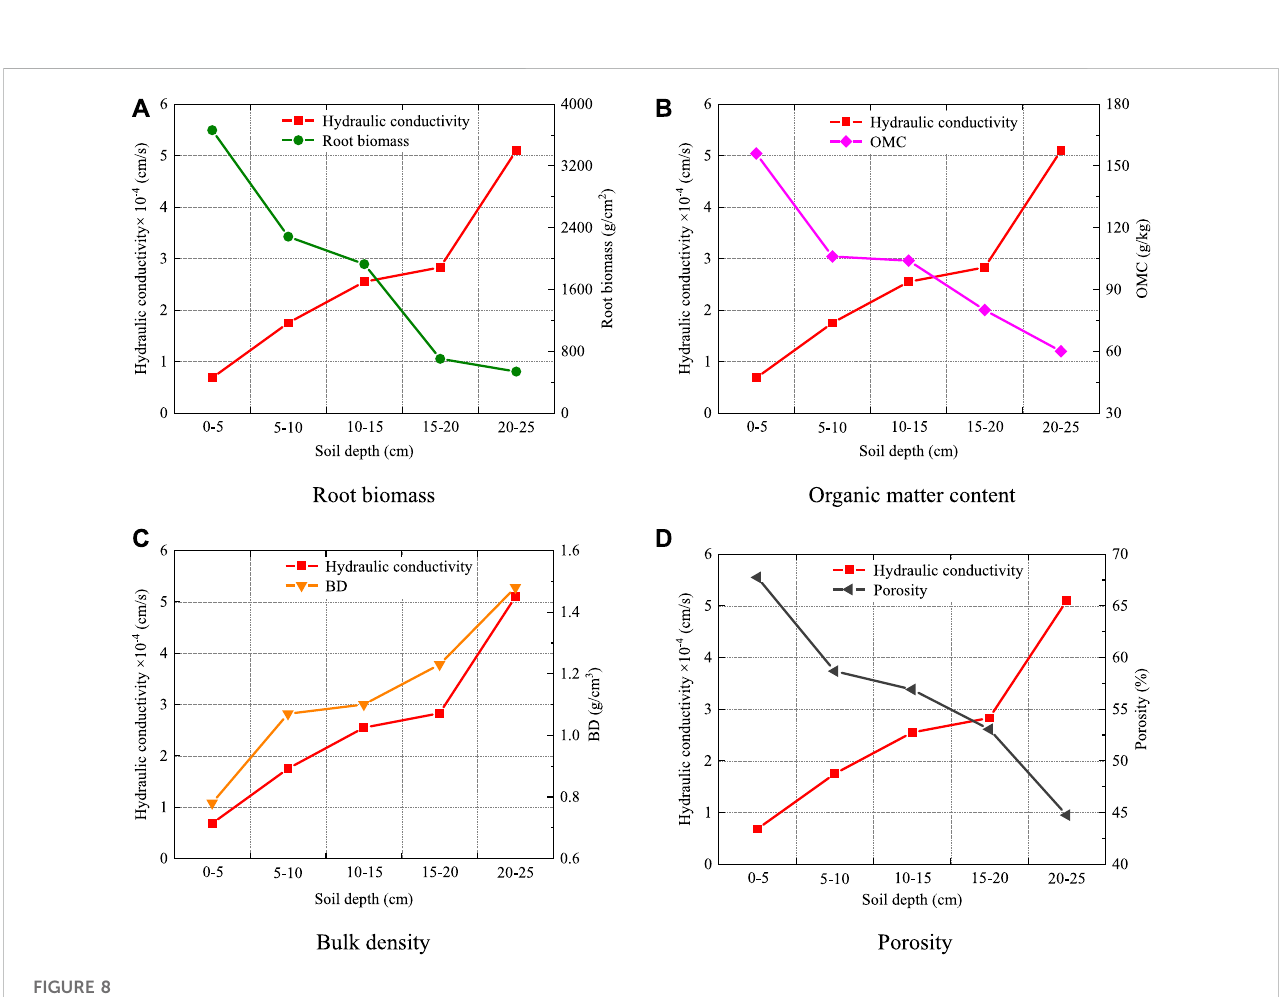
Relationship between hydraulic conductivity and (A) root biomass, (B) OMC, (C) BD, (D) porosity.